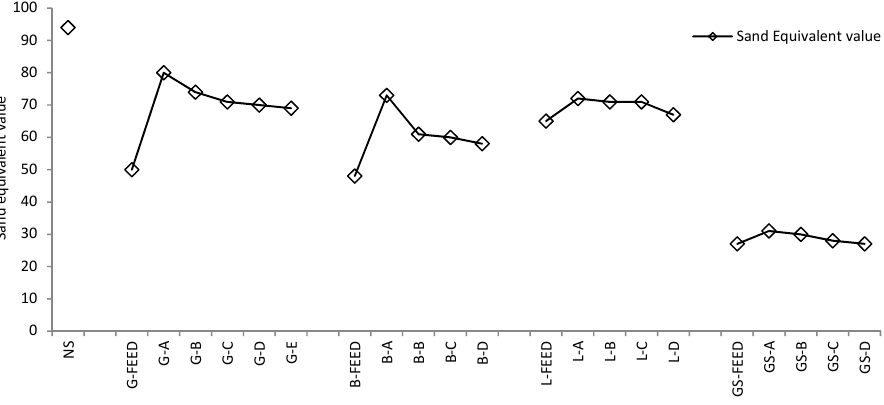
Figure 6. Sand equivalent value for fine aggregates.